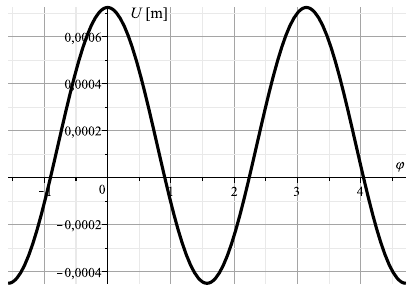
Figure 27: Plot of S ( φ ) (Example 5.3).